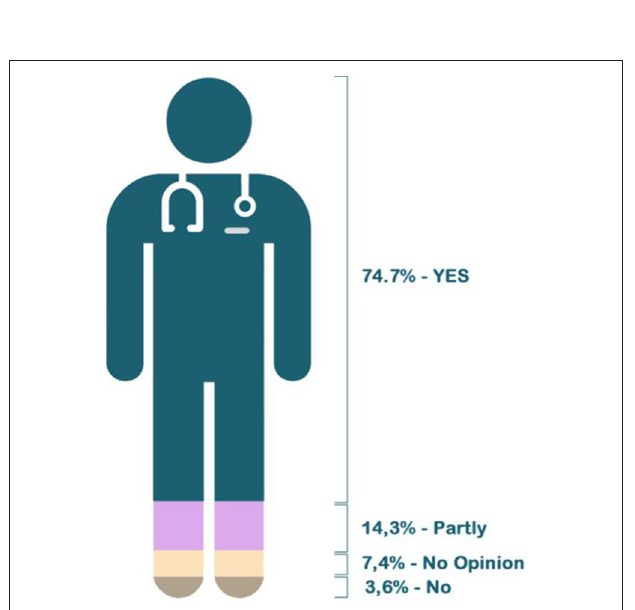
FIGURE 11 | AVASUS contribution to teamwork.